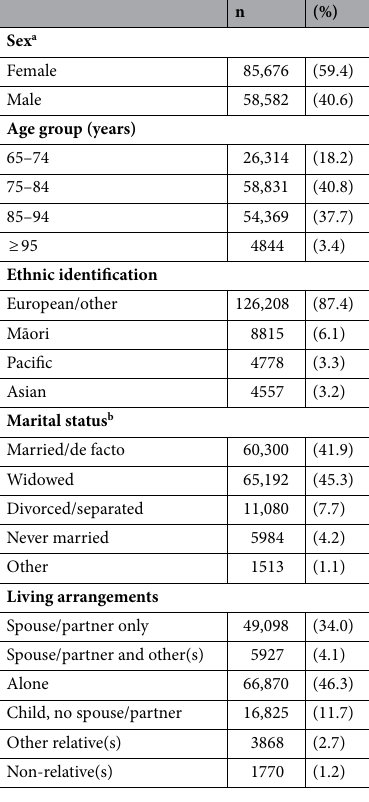
Table 1. Distribution of participants’ sociodemographic measures at their first interRAI-HC assessment. a Sex was unknown for 98 and indeterminate for 2 participants. b 289 values were